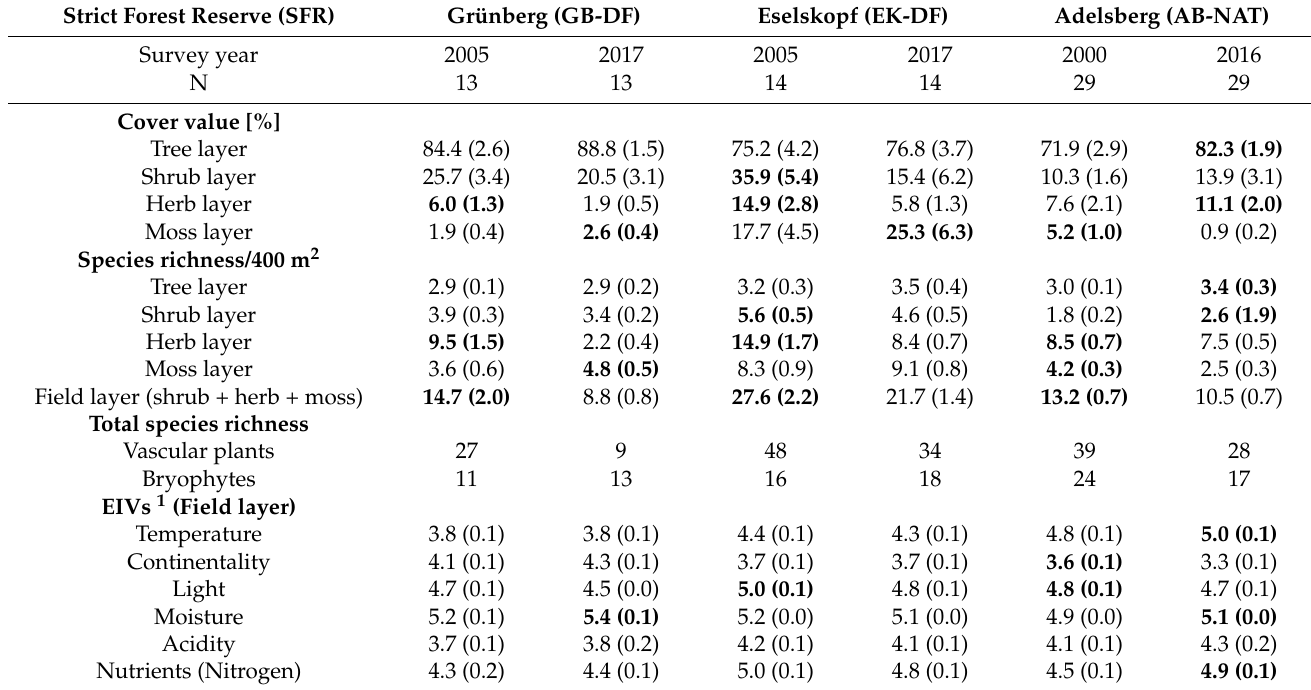
Table 2. Vegetation layer characteristics for the first and second survey. Given are mean values with standard error in parentheses. Significantly higher values ( p < 0.05) comparing both survey years are written in